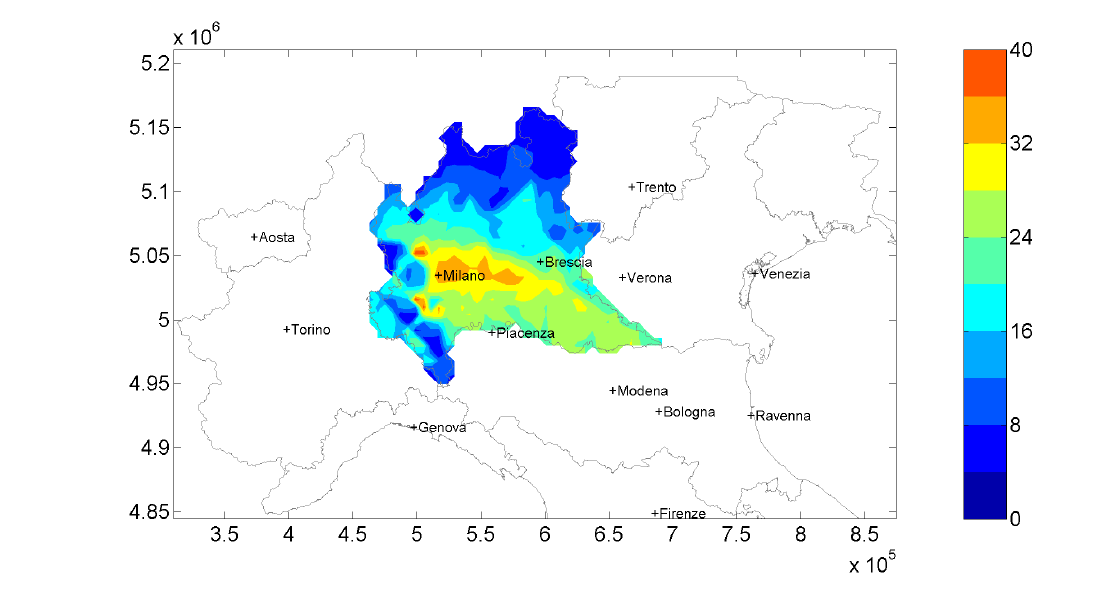
Figure 5. Maps of the yearly PM 10 average concentrations in [ µ g/m 3 ] for Policy A